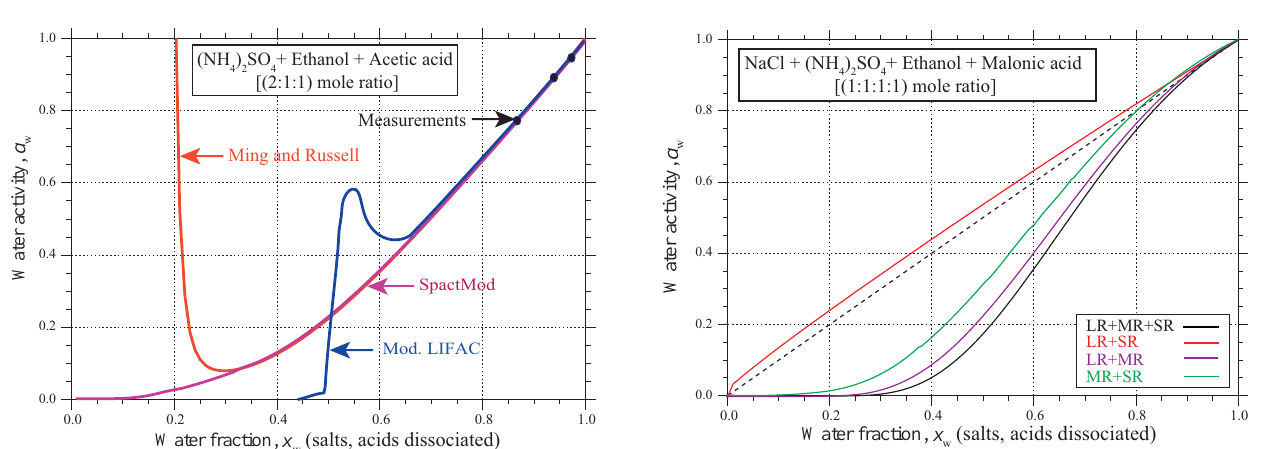
Figure 10. Comparison between measured and modeled water ac- tivities for the aqueous solution composed of organic-electrolyte mixture: (NH 4 ) 2 SO 4 + ethanol + acetic acid [(2:1:1) mole ratio].